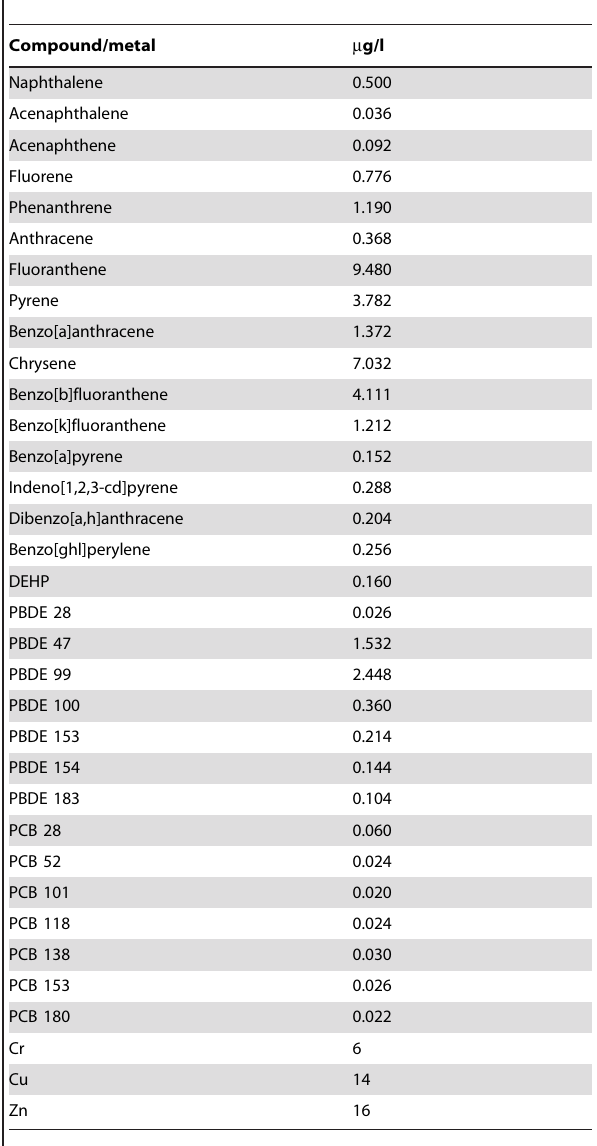
Table 1. Representative organic pollutants and potentially toxic metals contained in 1% sewage sludge